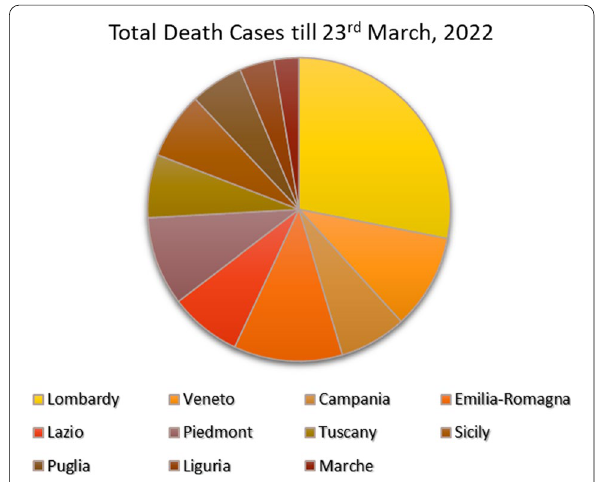
Fig. 2 Chart describing the death cases of major regions till 23 March